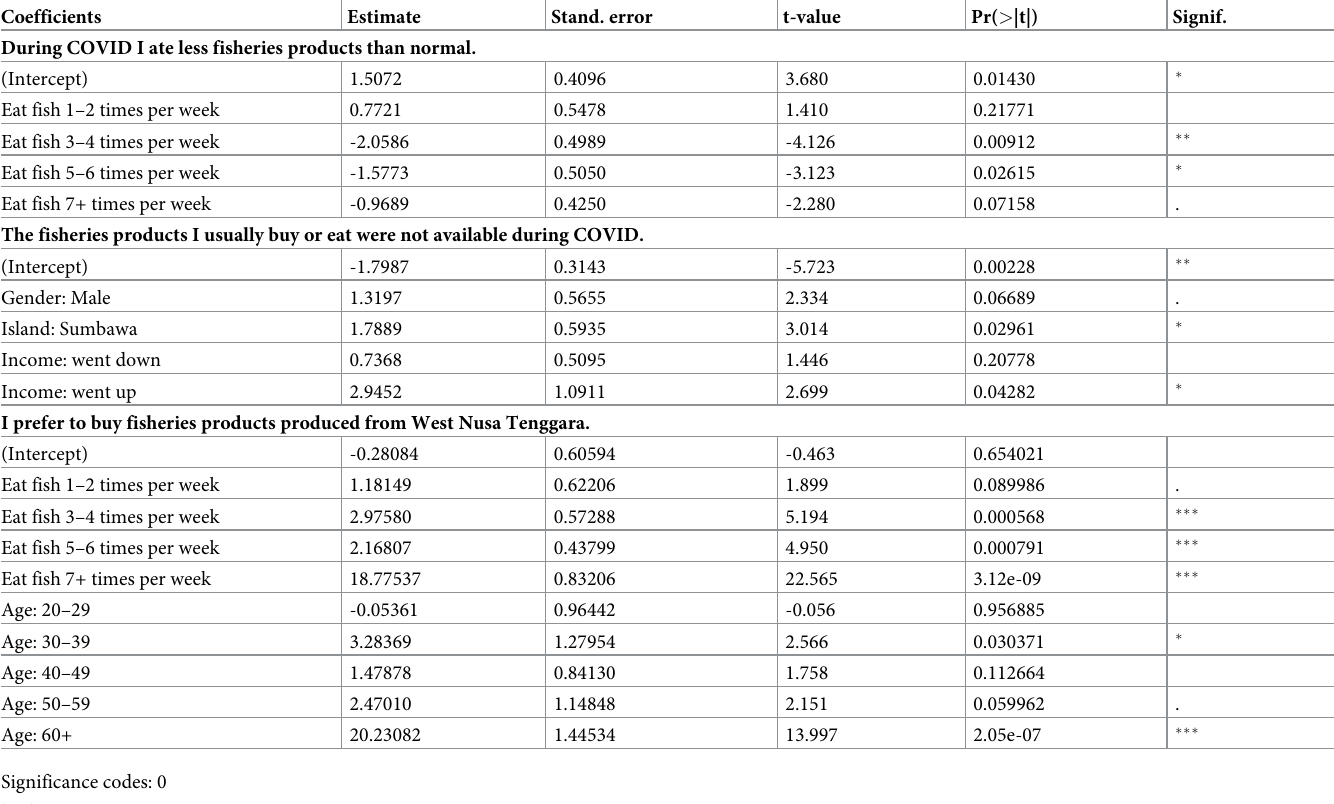
Table 3. Coefficients of the logistic regression models of the demographic and socioeconomic factors associated with seafood consumption change questions during COVID-19. Coefficients Estimate Stand.